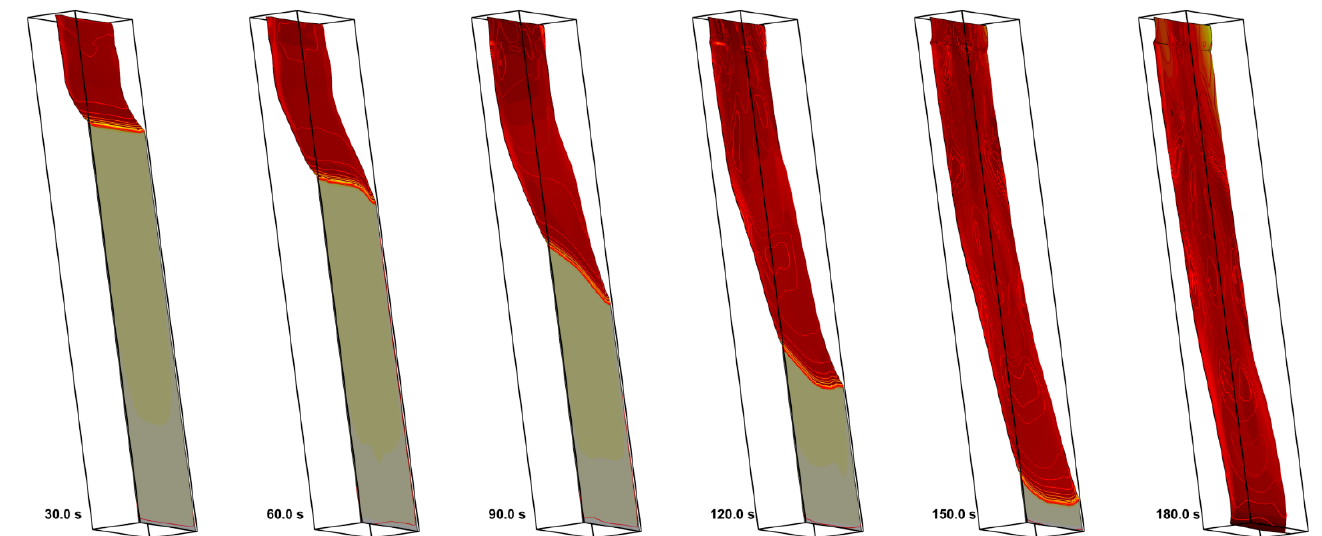
Figure 23. Visualization of downward flame spread at time instants in multiples of 30 s by variation of the layer thickness. The specimen surface is colored by the net heat flux received by the layer.